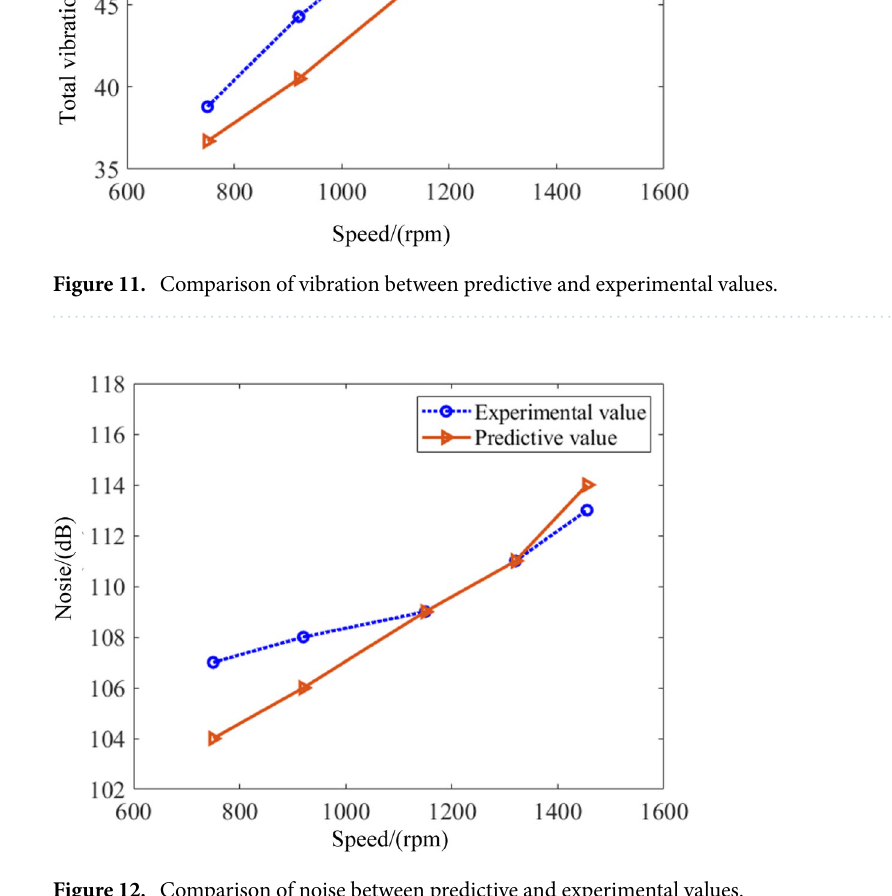
Figure 12. Comparison of noise between predictive and experimental